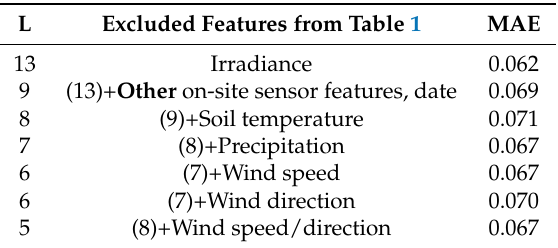
Table 5. Impacts of features on loss L Excluded Features from Table 1 MAE